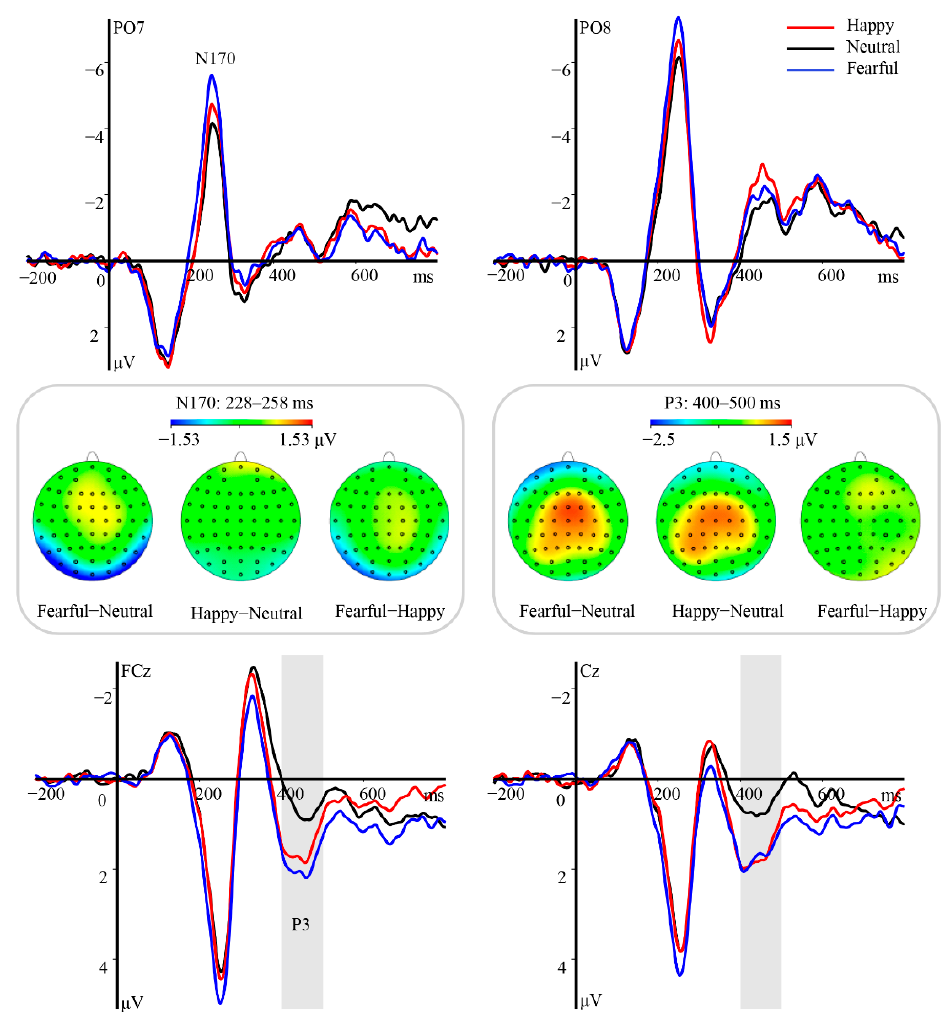
Figure 2. Modulation of the N170 and P3 components in response to emotional valence of eye region stimuli in Experiment 1. Top and bottom panels: Grand average ERP waveforms of N170 and P3 for happy (red line), neutral (black line), and fearful (blue line) eye regions at the indicated electrodes. The gray area indicates the time window of the P3 component (400–500 ms). Middle panel: Topographical difference maps depicting the effect of emotional valence in the eye region on the time windows for N170 and P3.